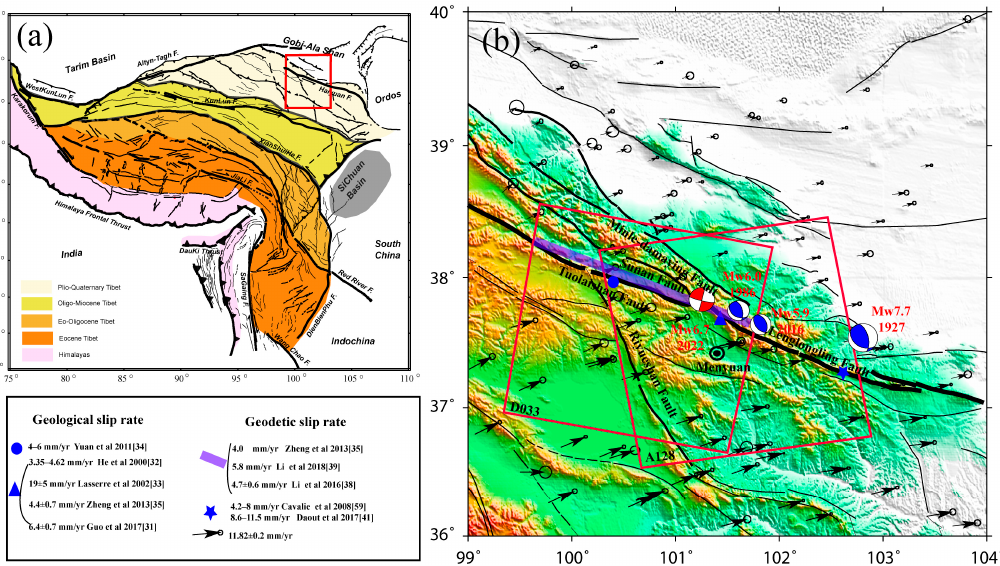
Figure 1. Tectonic setting of the 2022 Menyuan earthquake. ( a ) Main active faults in the Tibetan Plateau and the research scope of this study (red rectangle). ( b ) Active faults (black lines) and historical earthquakes located near the 2022 Menyuan earthquake and in the surrounding area. The bold black line represents the Qilian-Haiyuan Fault Zone (seismogenic fault of the 2022 earthquake), the red rectangle represents the Sentinel data range covering the study area, and the red beach ball diagram represents the 2022 Menyuan earthquake. The blue beach ball diagrams represent historical earthquakes in the study area, blue straight lines represent the range of fault slip rates obtained from the GNSS data, the blue star represents the range of fault slip rates obtained from the InSAR data, and blue dots and triangles represent the slip rates obtained using geological methods. Black arrows indicate the GNSS sliding rate in the study area